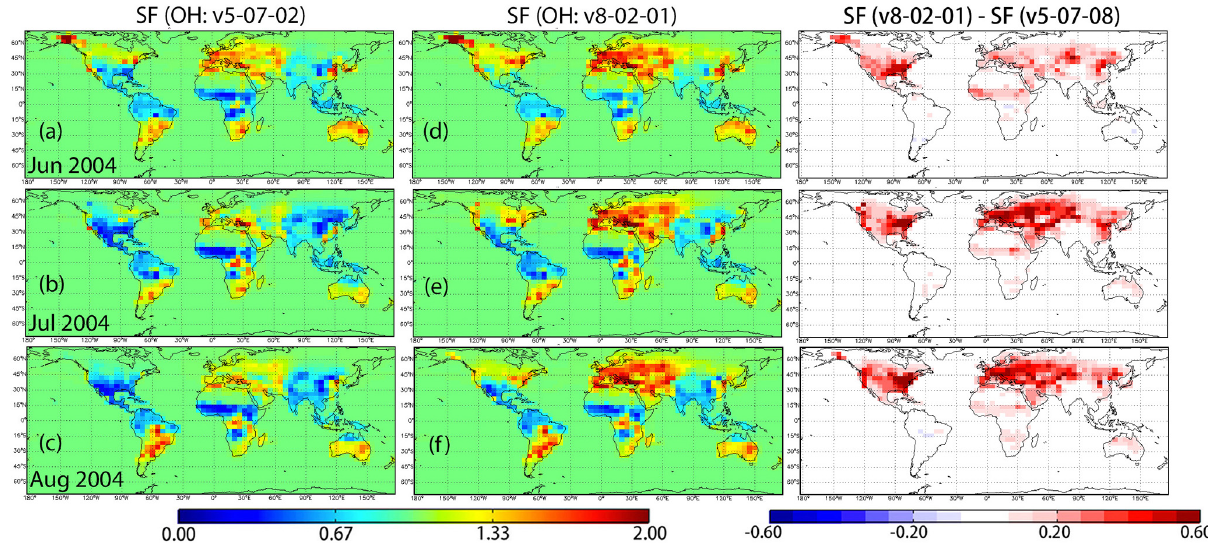
Figure 7. Scaling factors with MOPITT surface level retrievals and their difference. (a–c) Scaling factors, using v5-07-08 OH; (d–f) Scaling factors, using v8-02-01 OH; (i–l) Difference between two scaling factors.